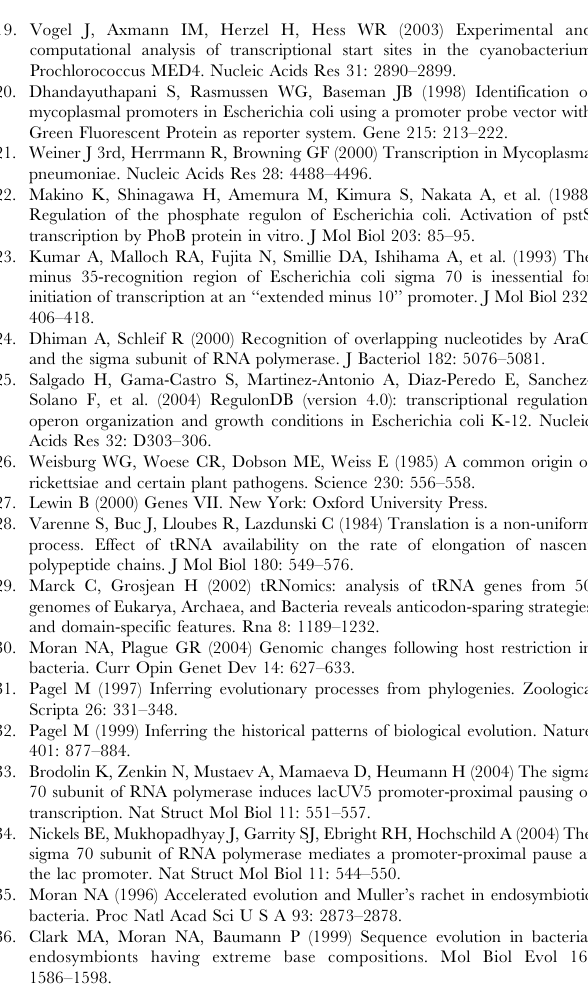
Table S1 List of 185 unique 2 10 hexamers derived from 584 experimentally detected s70 E. coli promoters. Table S2 Observed vs. expected counts of 2 10 motifs in regulatory regions. Total Sequence Length is the total number of base pairs analyzed for the corresponding type of region in each genome. NSD is the number of standard deviations that separate the observed motif count from the expected mean in that genome, NSD = (Obs-Mean)/SD.